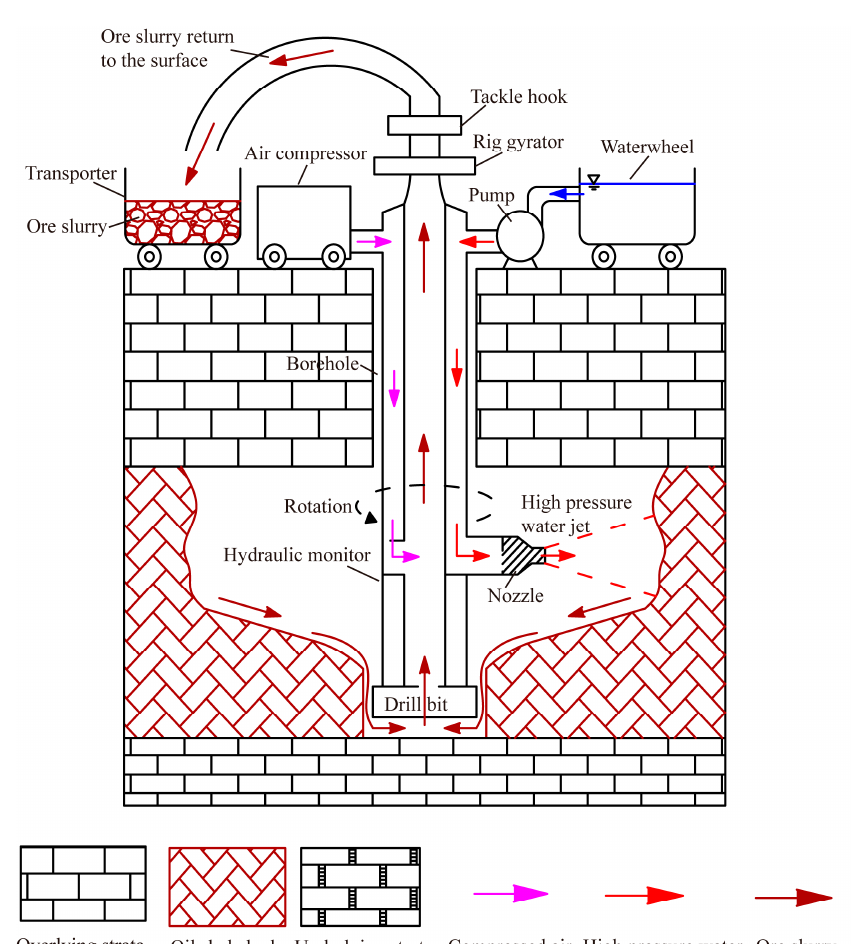
Figure 2. Schematic diagram of the borehole hydraulic mining technology.